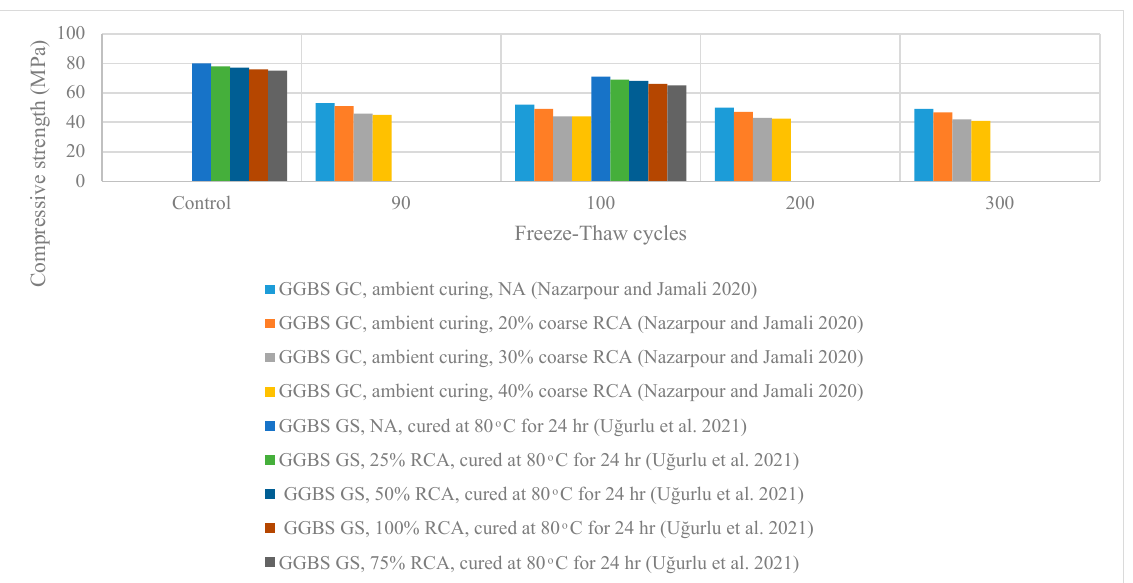
Figure 10. Relationship between the freezing and thawing cycles and CS [26,120].